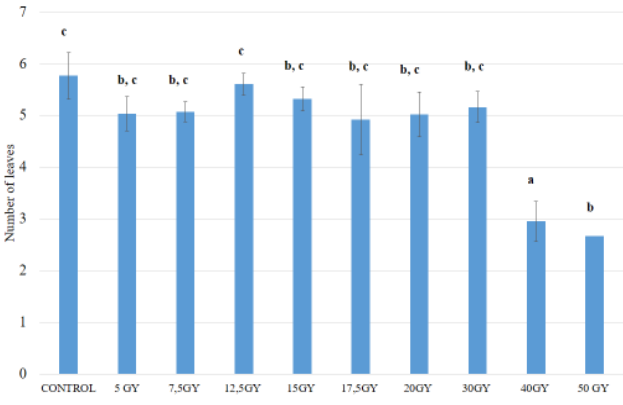
Figure 5. Number of adult leaves of the plants at different doses of radiation